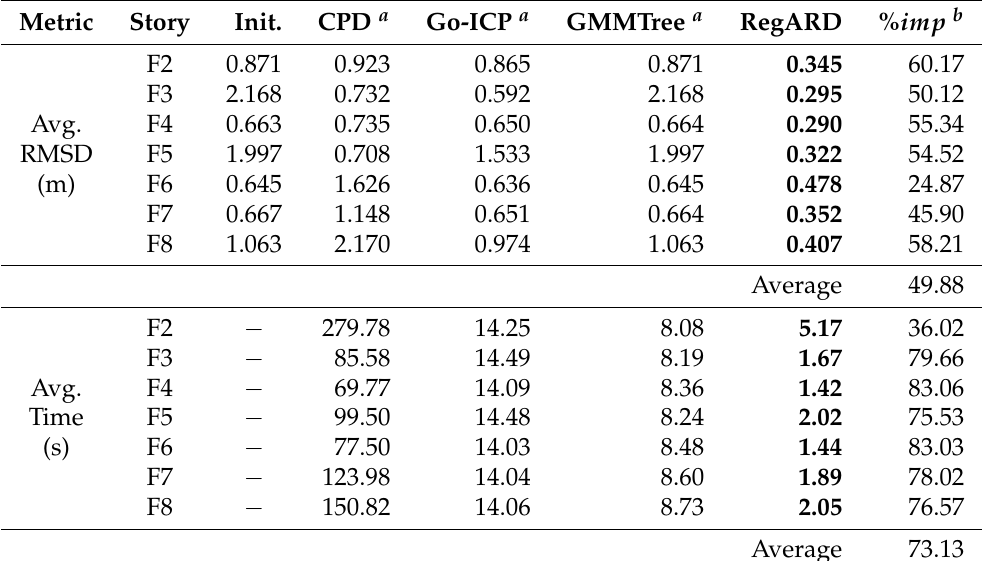
Table 2. Registration metrics of RegARD and other coarse registration algorithms (100 iterations, 10